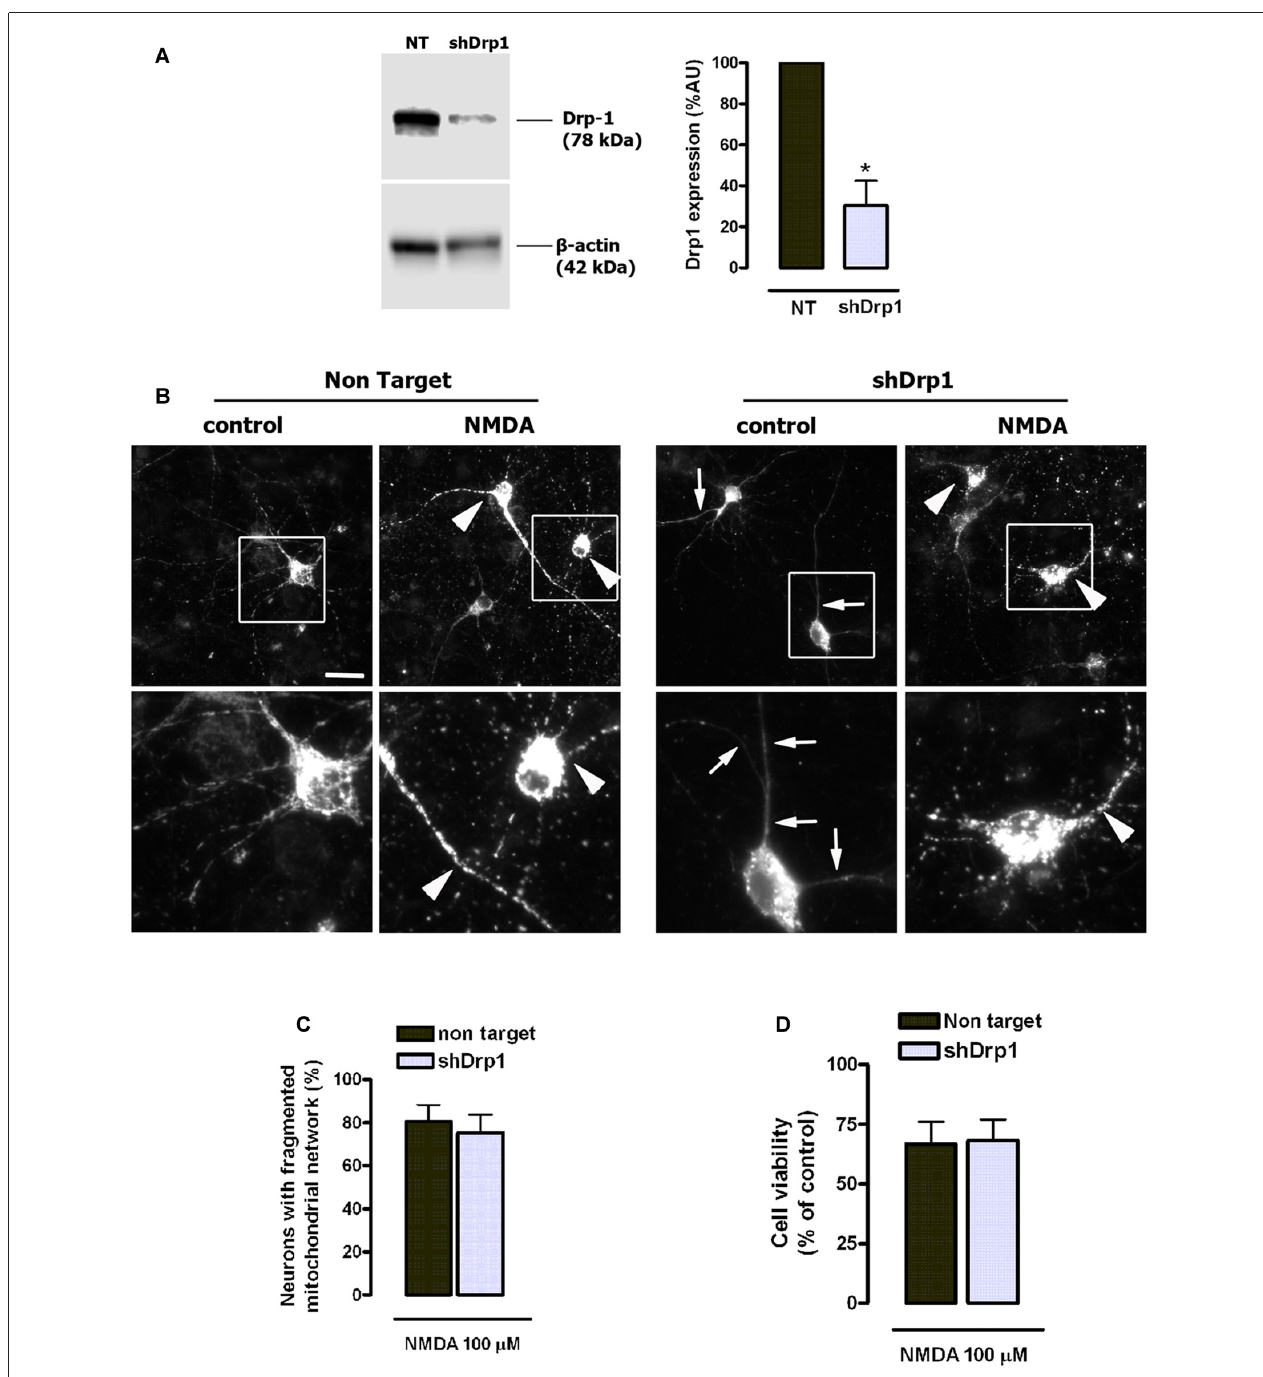
FIGURE 8 | NMDA-induced mitochondrial fission and toxicity is not prevented by dynamin related protein 1 (Drp1) knockdown. (A) After lentiviral delivery of shRNA and puromycin selection cells were harvested for the detection of Drp1 by western blot. Drp1 signal was measured and normalized to β -actin values ( n = 3). ∗ p < 0.05, compared with cells expressing non target (NT) shRNA, paired student’s t -test. (B) Representative images of NMDA-induced mitochondrial fragmentation in shRNA expressing neurons. Neurons transfected with mitochondria-targeted 2mtD4cpv and infected with shRNA-carrying lentiviruses were exposed to 100 µ M of NMDA for 30 min and fixed for mitochondrial morphology analysis. White boxes on top images correspond to zoomed fields (bottom row). Arrowheads indicate fragmented mitochondrial networks and arrows mark abnormally elongated mitochondrial network in Drp1-silenced neurons. Scale bar: 20 µ M. (C) Mitochondrial morphology analysis was performed by the quantification of cells with fragmented mitochondrial network in neurons expressing NT shRNA ( n = 179 cells) and shDrp1 ( n = 167 cells). Paired Student’s t -test. (D) Neurons were treated as in (B) and 24 h later cell viability was assessed by the quantification of calcein-AM fluorescence ( n = 3). Data represent means ± SEM of normalized calcein fluorescence values, paired Student’s t test.